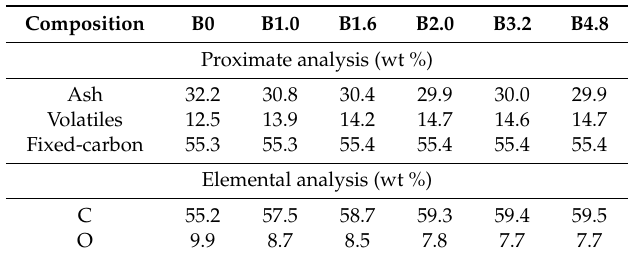
Table 2. Compositions of